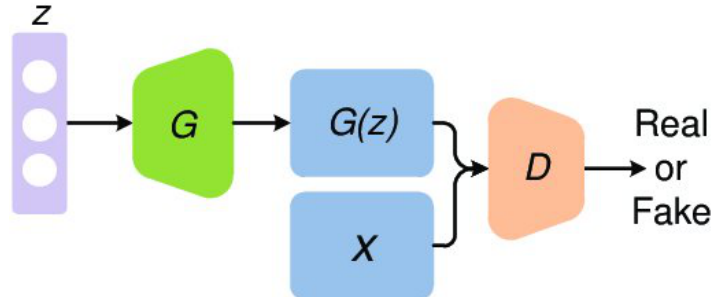
Figure 5. Architecture of generative adversarial networks (GAN) [29].